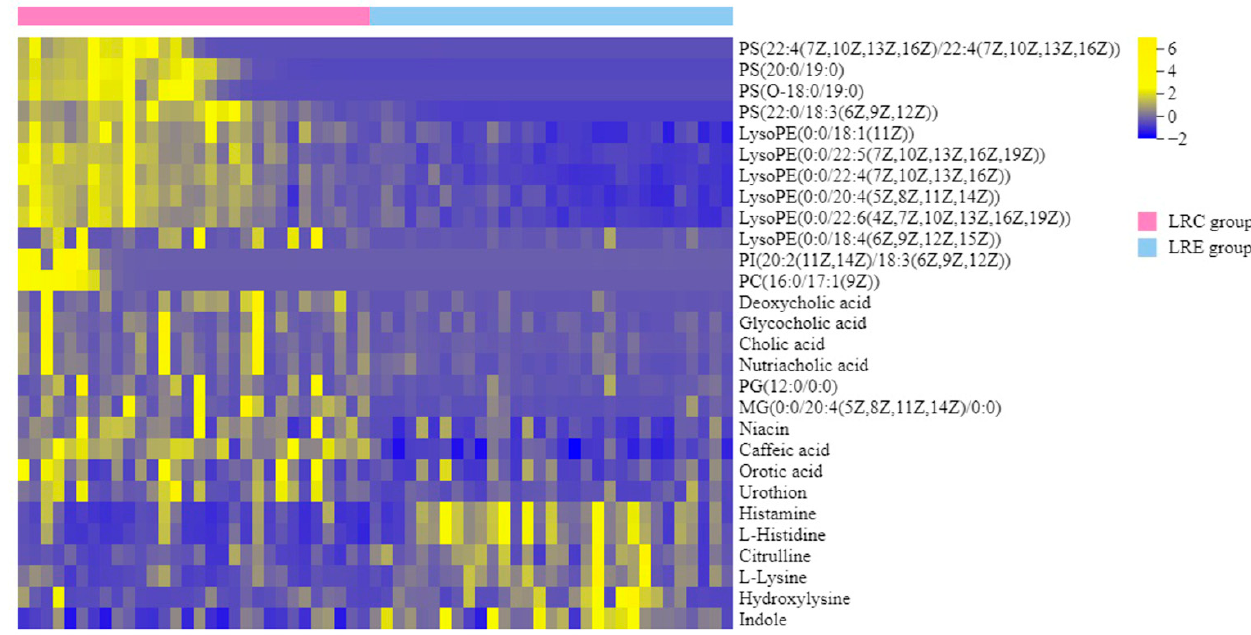
Figure 3. Heat map of the characteristic metabolites closely related to centenarians from the longevous region. The color scale correlates with the normalized quantities of the characteristic metabolites in samples: yellower color indicates higher quantities, and bluer color indicates lower quantities. Each row represents one characteristic metabolite, and each column represents one participant. Pink denotes the participants in the LRC group (left side), and blue denotes the participants in the LRE group (right side). It is more obvious to display a marked difference between the LRC group and LRE group, revealing some unique remodeling of amino acid metabolism and lipid metabolism of the healthy centenarians, compared with the elderly people aged 60–70 years. LRC, centenarians in the longevous region; LRE, elderly people aged 60–70 years in the longevous